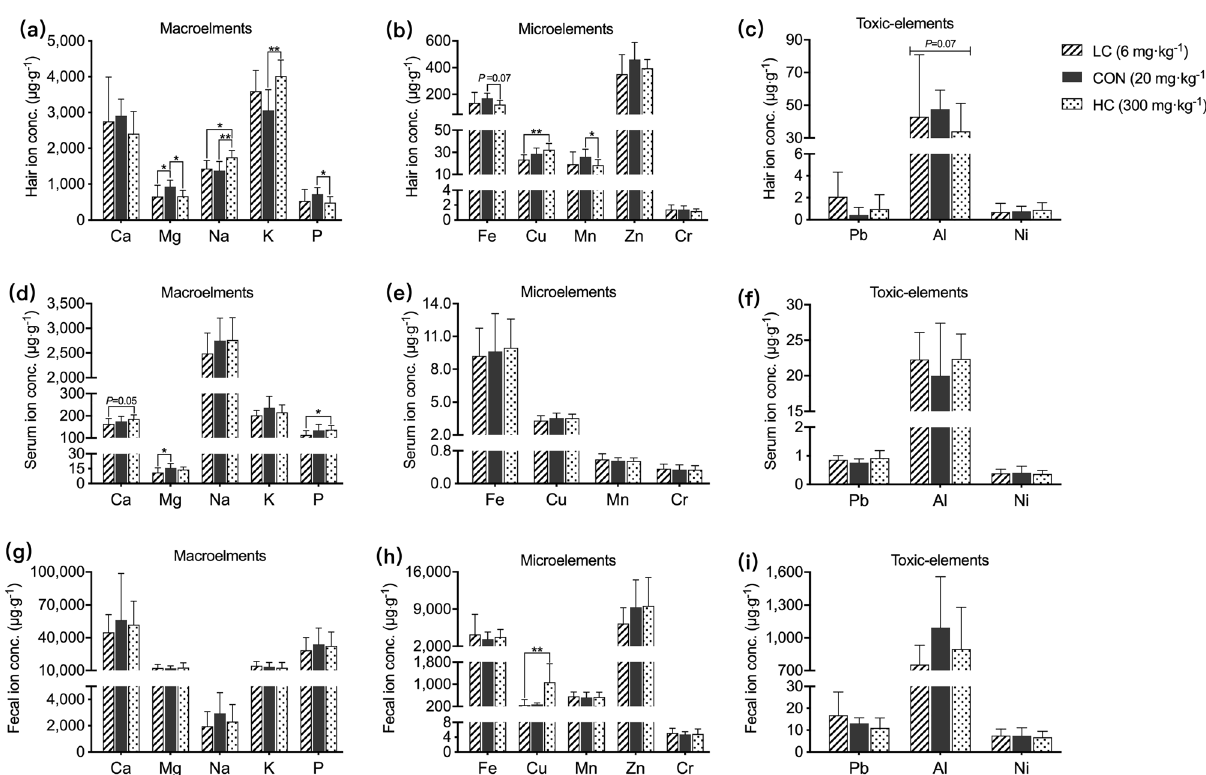
Figure 1. Effect of dietary copper levels on hair, serum and fecal ion concentrations in suckling piglets. Over all changes of 13 elements in hair ( a , b , c ), serum ( d , e , f ), and feces ( g , h , i ) among each dietary group. * denote P < 0.05, ** denote P <